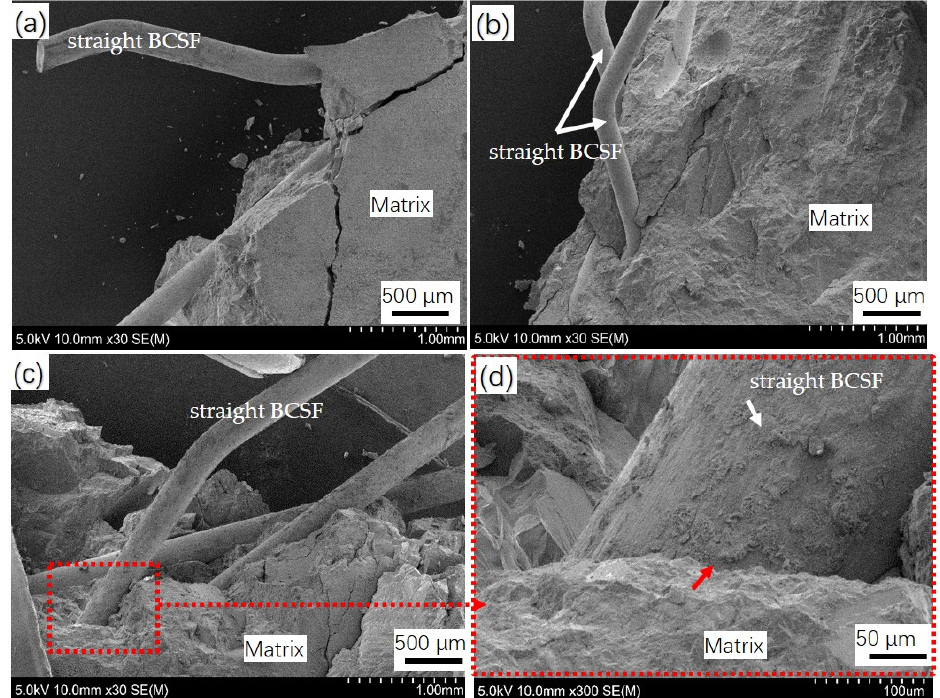
Figure 14. SEM imagines of crack growth of straight BCSF-reinforced UHPC of different content cured for 28 days after compressor strength test: ( a ) 2 wt.%; ( b ) 4 wt.%; ( c ) 6 wt.%; ( d ) magnified image in the red box area of ( c